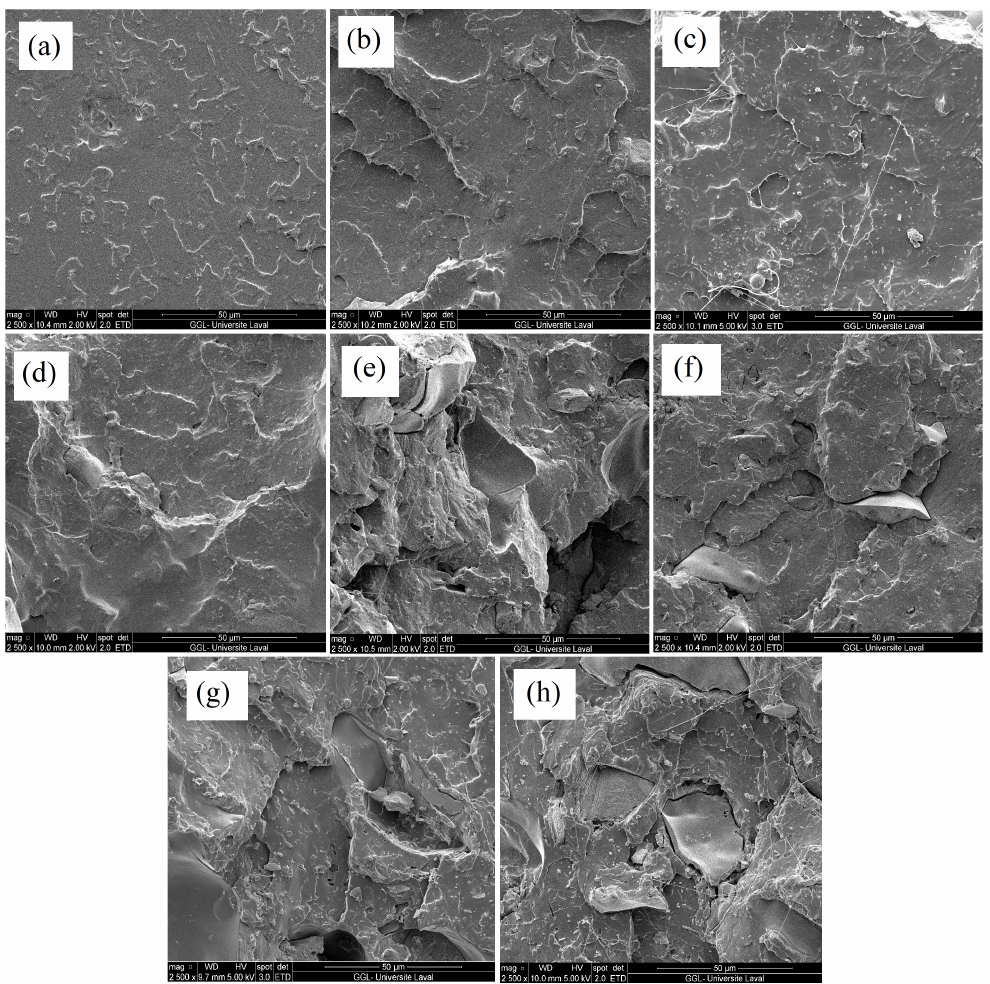
Figure 11. SEM micrograph of the tensile test rupture surface of: ( a ) neat PLLA, ( b ) PLLA/SiO 2 (95/5), ( c ) PLLA/SiO 2 (90/10), ( d ) PLLA/SiO 2 (85/15), ( e ) PLLA/SiO 2 /PEG (90/10/3), ( f ) PLLA/SiO 2 /PEG (90/10/5), ( g ) PLLA/SiO 2 /PEG (90/10/8), ( h ) PLLA/SiO 2 /PEG